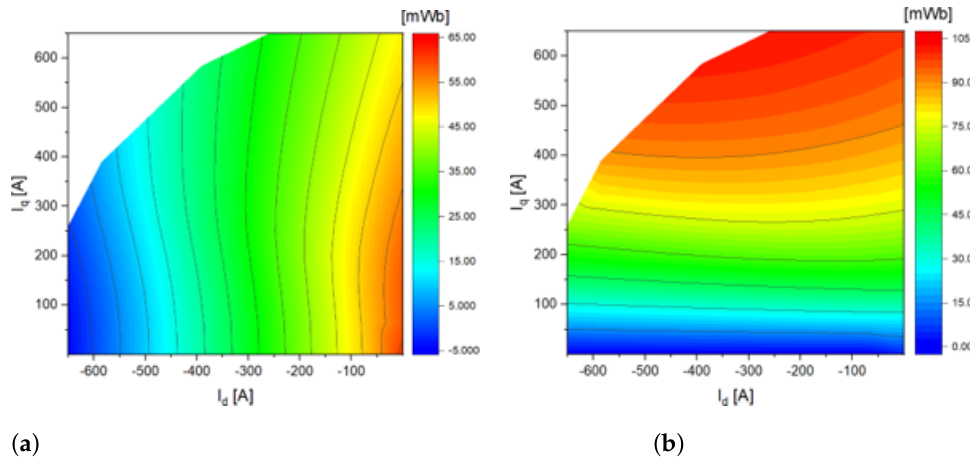
Figure 5. Flux linkage data map based on the d-q currents: ( a ) d- axis ( b ) q- axis. Table 2. Computation time for obtaining data map of both